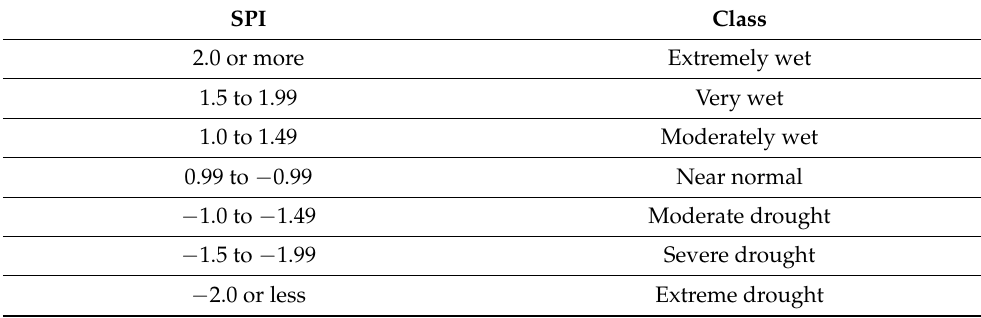
Table 1. SPI drought severity classes for wet and dry periods [26].